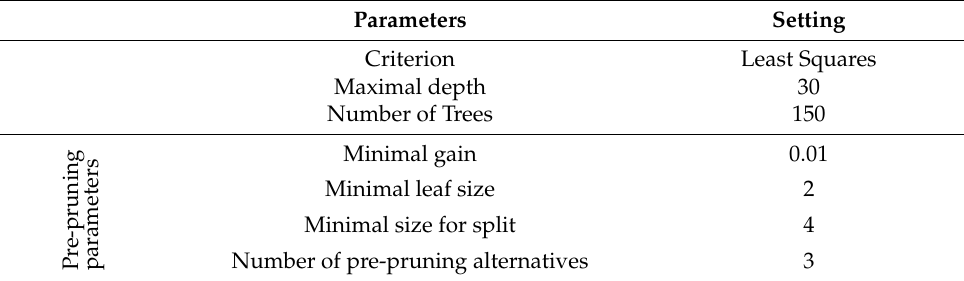
Figure 5. ( a ) Electrical consumption load trend in 10 years (from 2010 until the end of 2019); ( b ) Hourly electrical consumption load in a sample year (2019); ( c ) Hourly wind speed in a sample year (2019); ( d ) Hourly Temperature in a sample year (2019). Table 1. Hyperparameters of Random Forest (RF) model that considered for optimization.